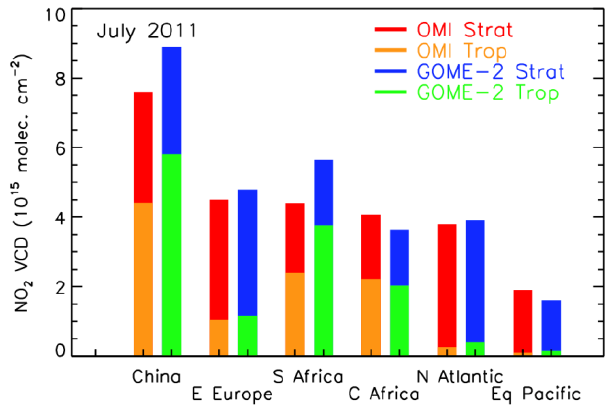
Figure 12. Mean tropospheric and stratospheric NO 2 VCDs re- trieved using the new version SPv3 over several polluted and un- polluted regions: China: 110–125 ◦ E, 30-42 ◦ N; eastern Europe: 33–48 ◦ E, 42–50 ◦ N; southern Africa: 25–35 ◦ E, 22–30 ◦ S; central Africa: 10–30 ◦ E, 0–14 ◦ S; North Atlantic: 25–3 ◦ 5W, 45–51 ◦ N; and equatorial Pacific: 150–160 ◦ W, 5 ◦ S–5 ◦ N. In all cases, the GOME-2 data have been adjusted to the local time of the OMI over- pass by making a photochemical correction to the stratospheric por- tion of the total column, based on the diurnal variation simulated by the GMI